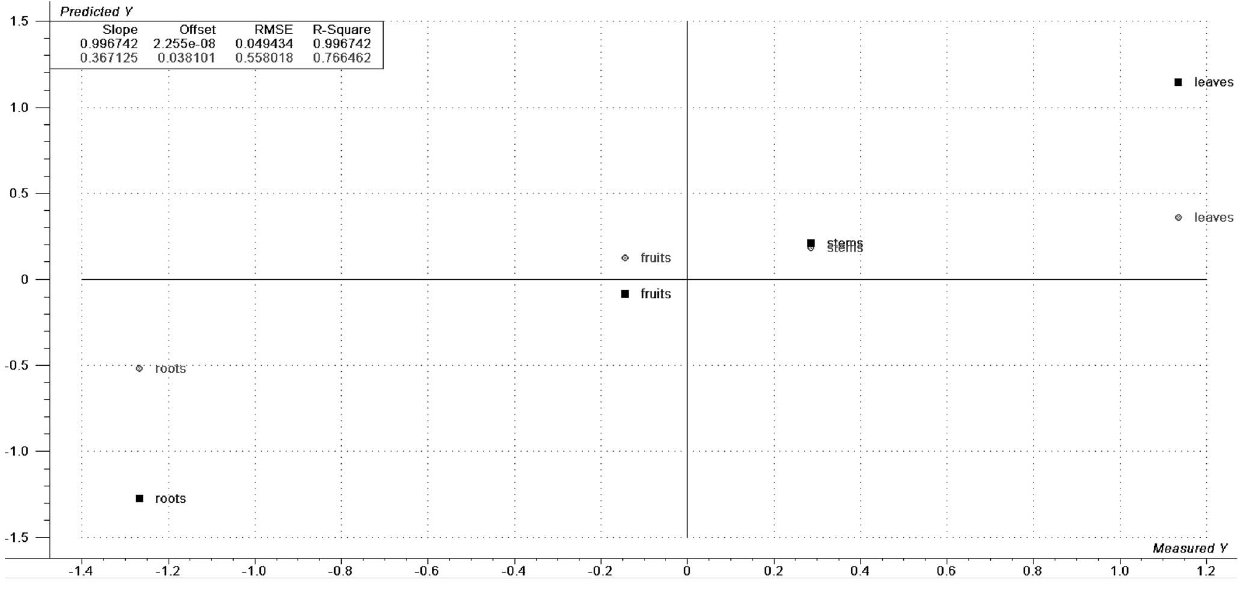
Figure 1. Calculated (squares) and predicted (circles) PLS data. These data were generated from ESIMS data, versus measured and autoscaled LC